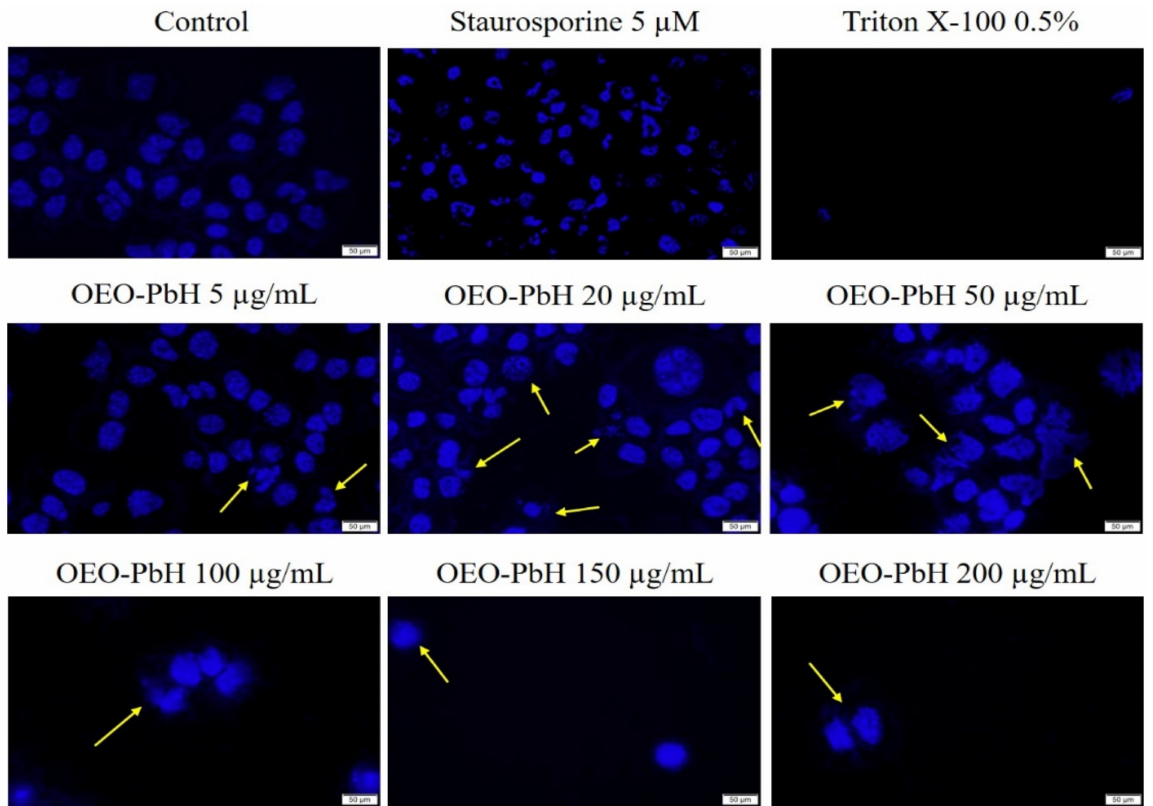
Figure 7. Hoechst staining in HaCaT cell line following OEO-PbH (5, 20, 50, 100, 150, 200 µ g/mL) stimulation (72 h). Staurosporine (5 µ M) was used as an indicator for apoptosis induction and Triton X-100 (0.5%) for necrosis. The scale bar represents 50 µ